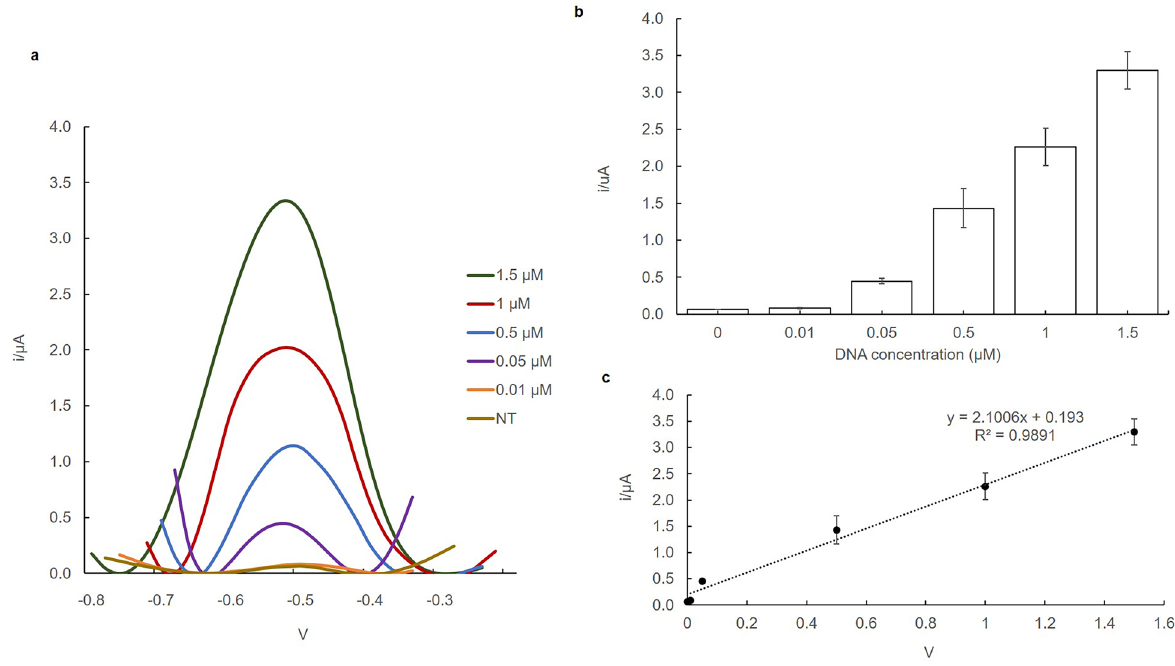
Figure 2. Differential pulse voltammogram signal of AcMP-AuNP-based DNA modified carbon SPEs electrode upon hybridization with different concentration of DNA target (1.5 µM, 1 µM, 0.1 µM, 0.05 µM, and 0.01 µM), and non-complementary (NC) ( a ), and the bar chart response range of the target DNA hybridized to DNA probe on acrylic microsphere ( b ). The linear response range for hybridization reaction between target DNA and DNA probe on AcMP-AuNP modified carbon SPE ( c ). The DPV peak rate was observed at − 0.55 V to − 0.45 V/s versus Ag/AgCl reference electrode in the presence of 10 mM AQMS. Error bars are standard deviations across three repetitive experiments.